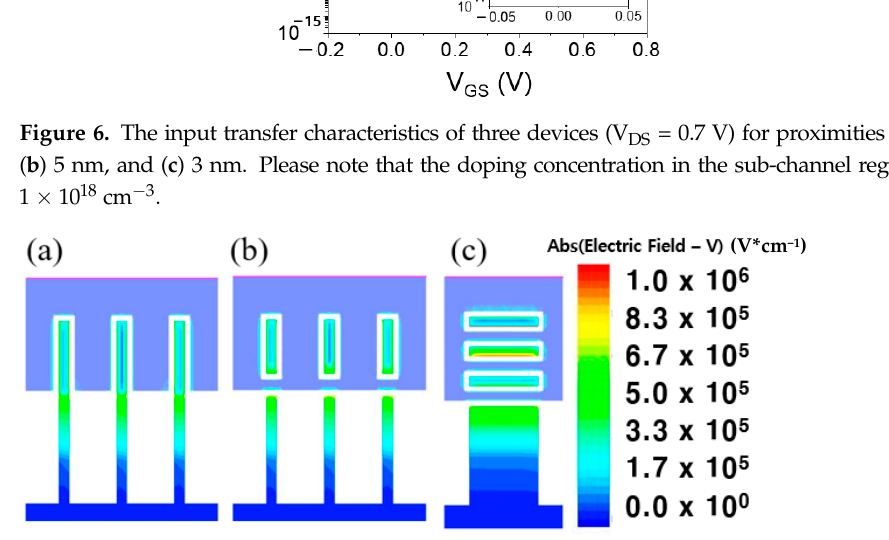
Figure 7. Cross-sectional views of electrical field density in ( a ) FinFET, ( b ) GAA-FinFET, and ( c ) NSFET.